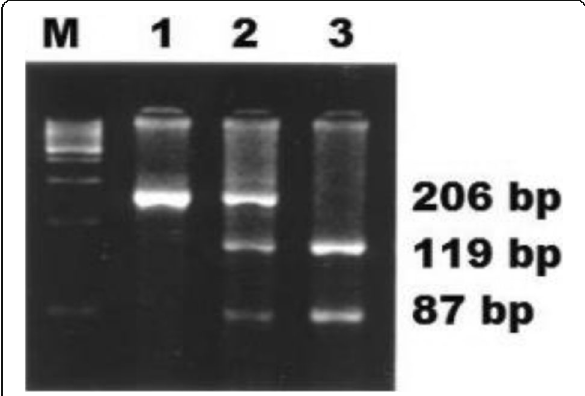
Fig. 2 PCR-RFLP analysis on agarose gel of G894T eNOS polymorphism. M: size marker; Lane 1: GG; Lane 2: GT; Lane 3: